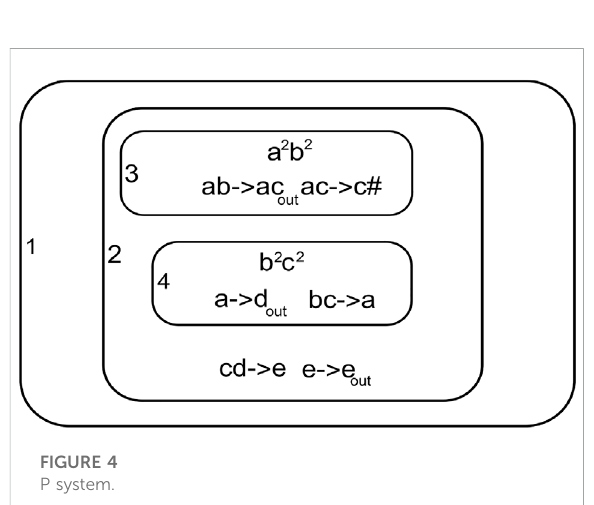
FIGURE 3 P system.